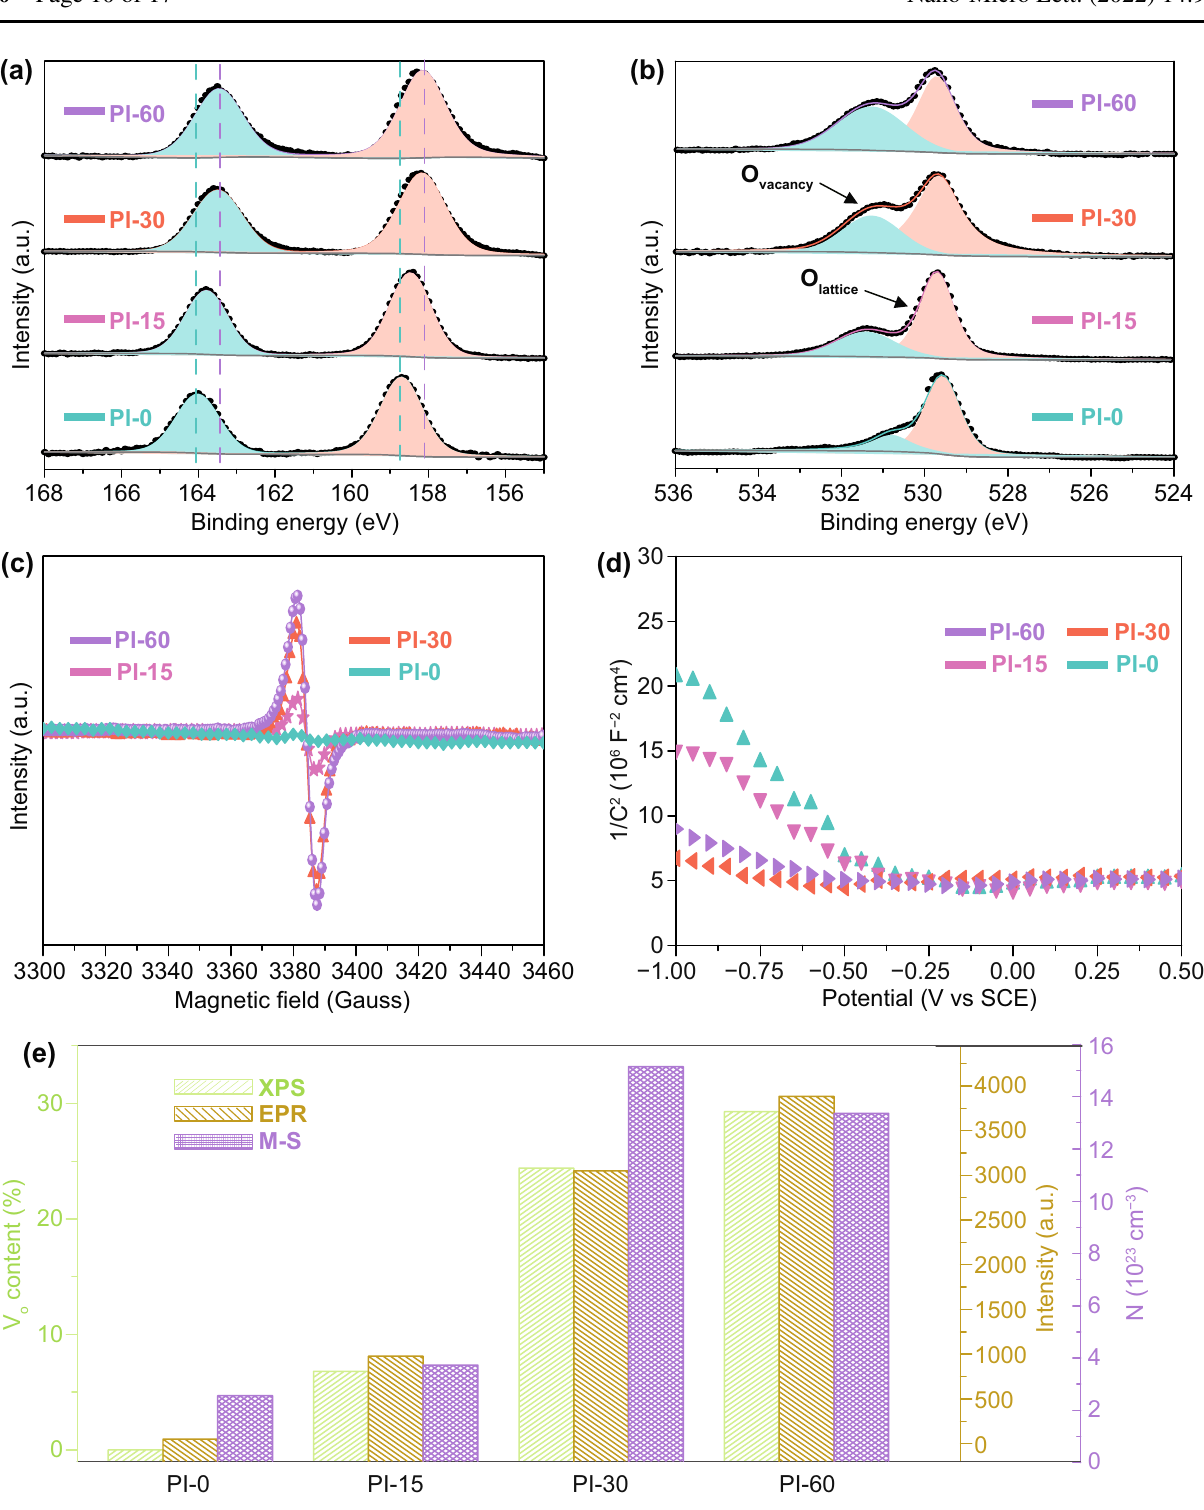
Fig. 4 Chemical states and oxygen vacancy evolution of 2D Bi 2 O 3 nanosheets upon plasma irradiations. High resolution XPS spectra of Bi 4 f ( a ) and O 1s ( b ) bands, electron paramagnetic resonance (EPR) spectra ( c ), the Mott-Schottky plots ( d ) of Pl-0, Pl-15, Pl-30, and Pl-60 samples. The variation of oxygen vacancy concentration of 2D Bi 2 O 3 with plasma irradiation time calculated based on the XPS, EPR, and